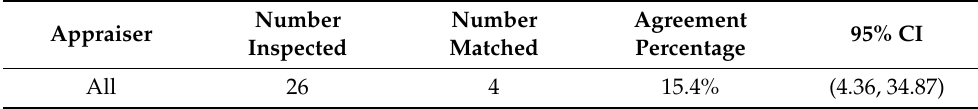
Table A4. Inspection Reproducibility (Agreement between Appraisers).